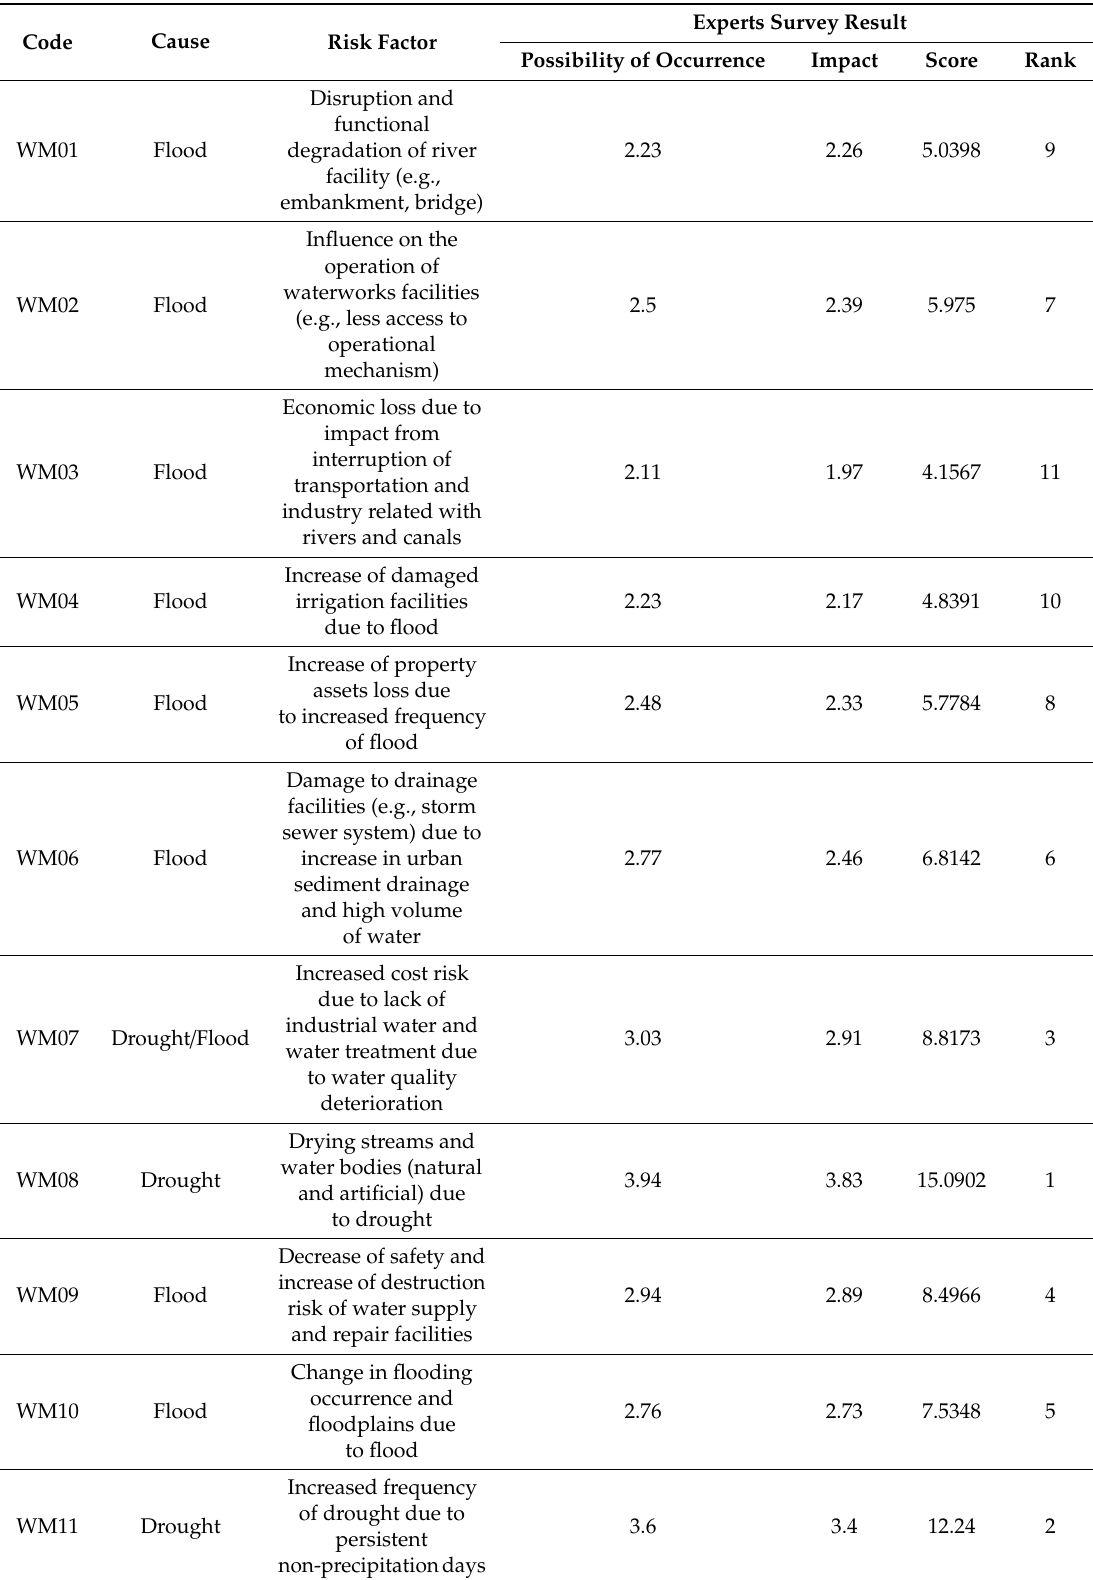
Table A2. WM risk factors and assessment result of